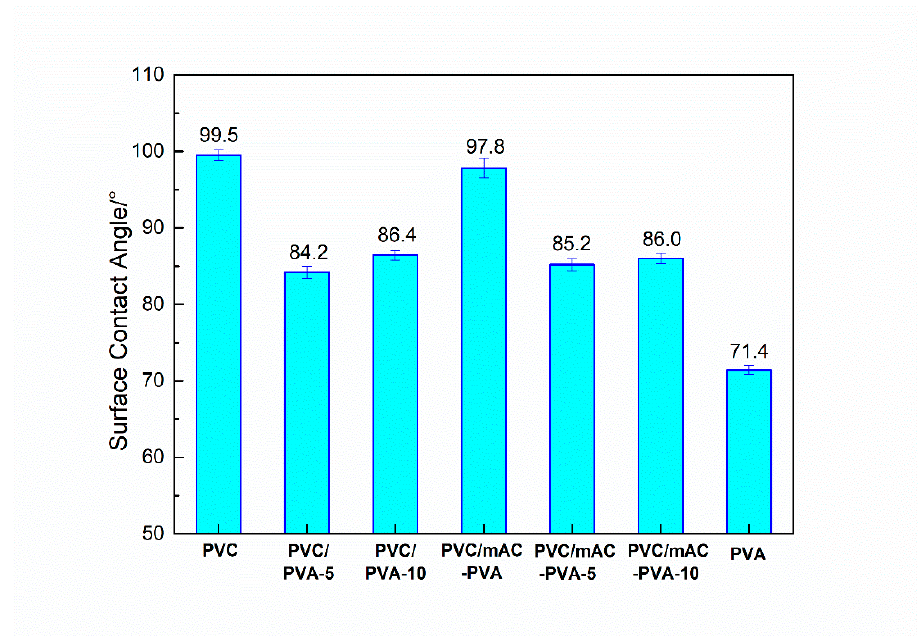
Figure 4. Surface contact angle of the PVC biofilm carrier. Polymers 2020 , 12 , x FOR PEER REVIEW